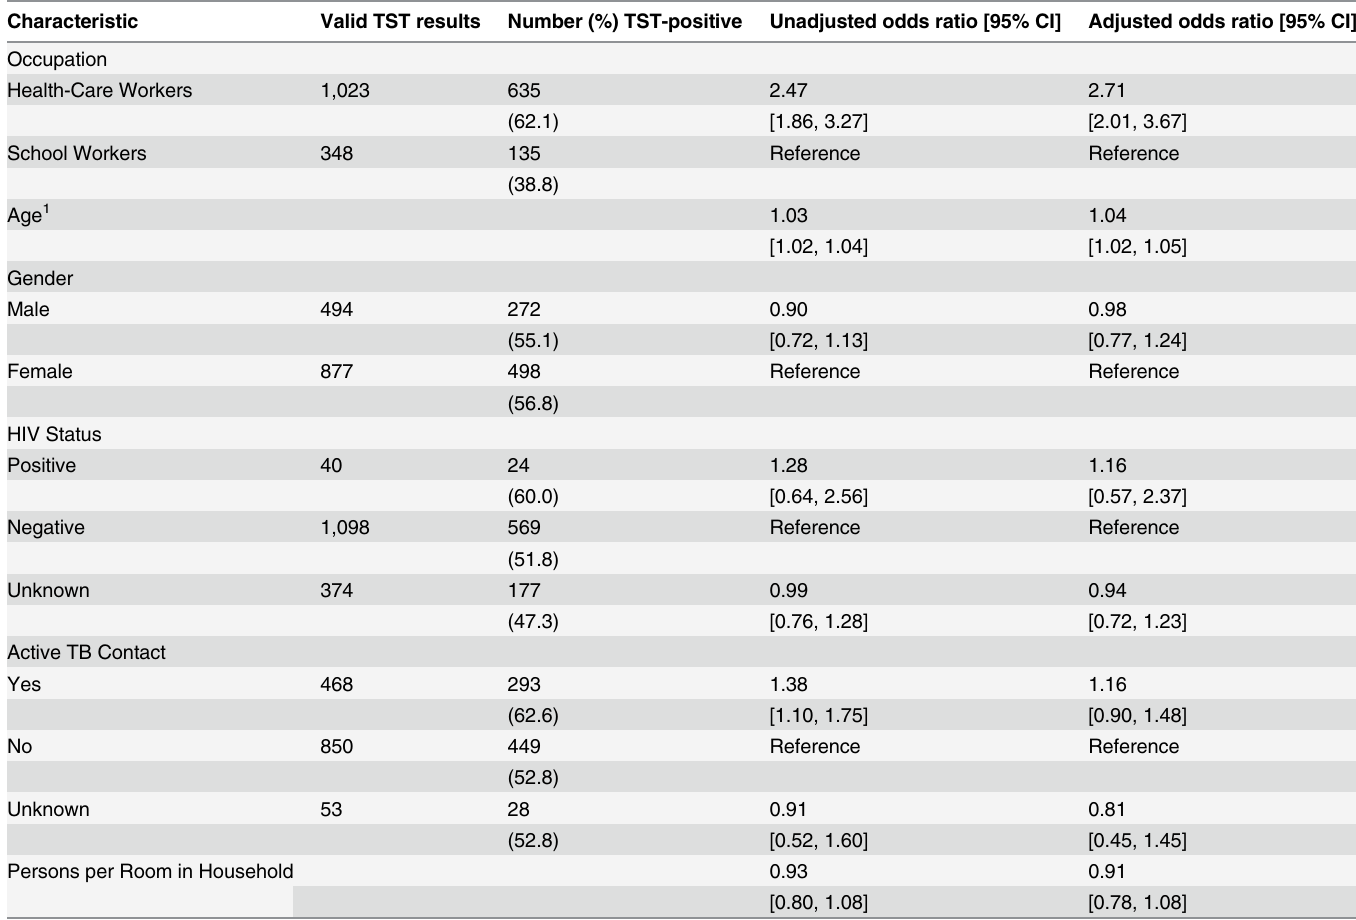
Table 2. Odds ratios for latent TB infection, as identified by TST results, among health-care workers relative to school workers from Kigali, Rwanda, before and after adjusting for potential confounders.